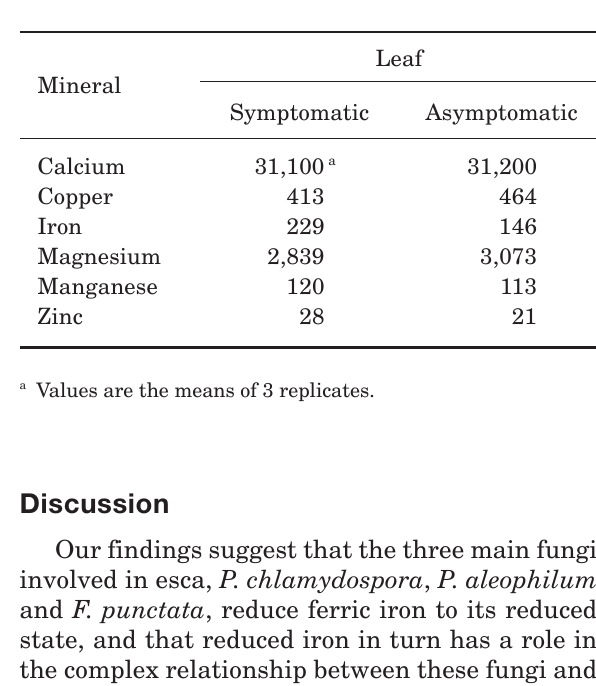
Table 2. Mineral content (mg kg -1 ) of symptomatic and asymptomatic leaves of grapevine infected with esca, as determined by atomic absorpion